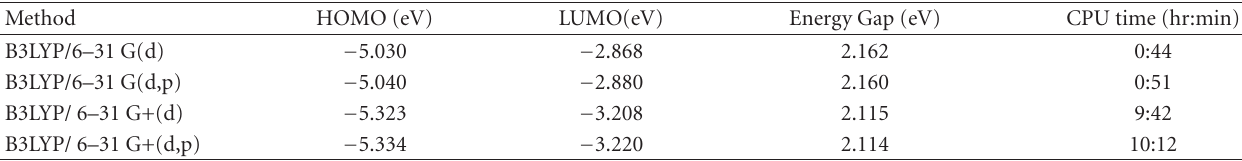
Table 1: HOMO, LUMO, energy gap, and CPU times yielded from the B3LYP method at di ff erent sizes of the basis sets for PTP, where R = R (cid:2) = –H, θ = 109 ◦ , and φ = 80 ◦ (see Figure 2 for